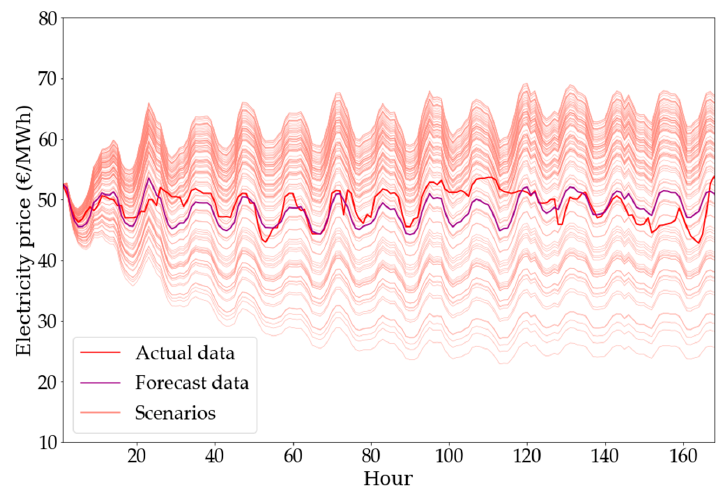
Figure 7. Electricity actual price time series, forecasts, and one hundred scenarios.